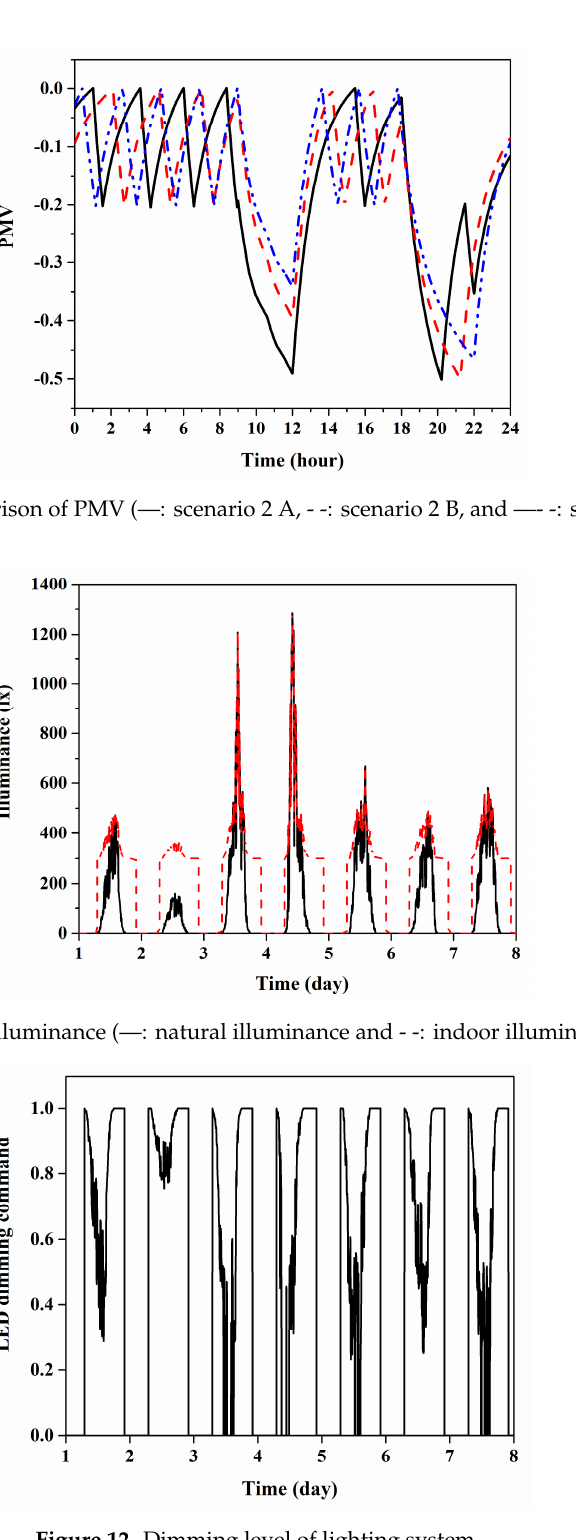
Figure 12. Dimming level of lighting system.